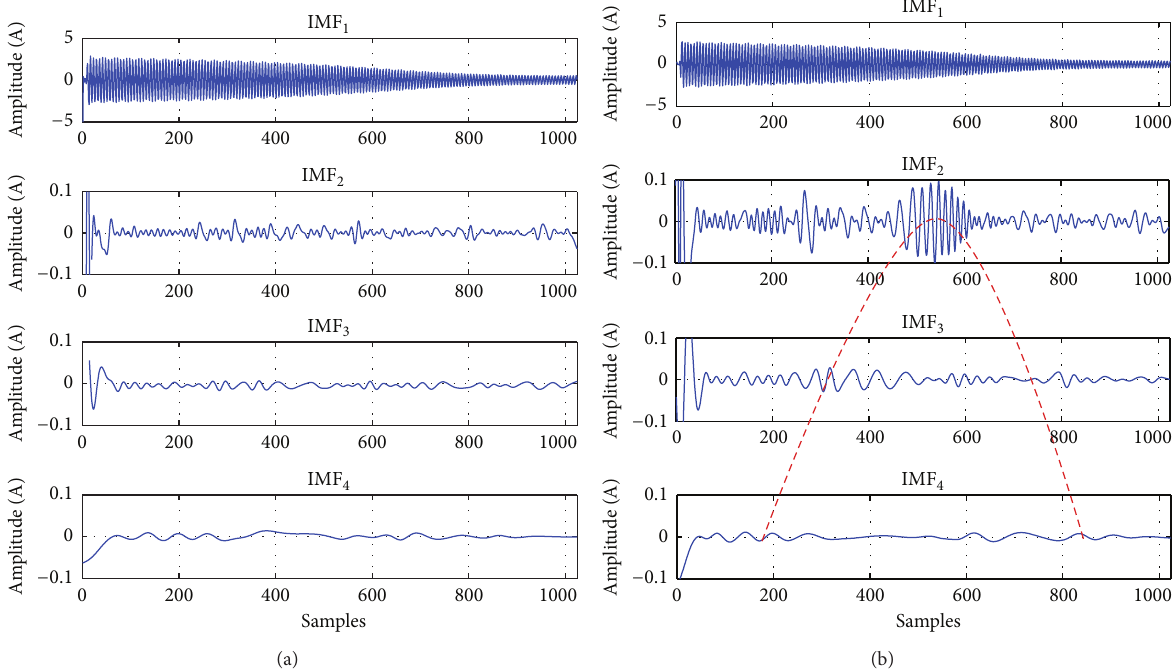
Figure 1: IMF signal decomposition for a current signal of an induction motor: (a) healthy motor and (b) faulty motor with two broken rotor bars.